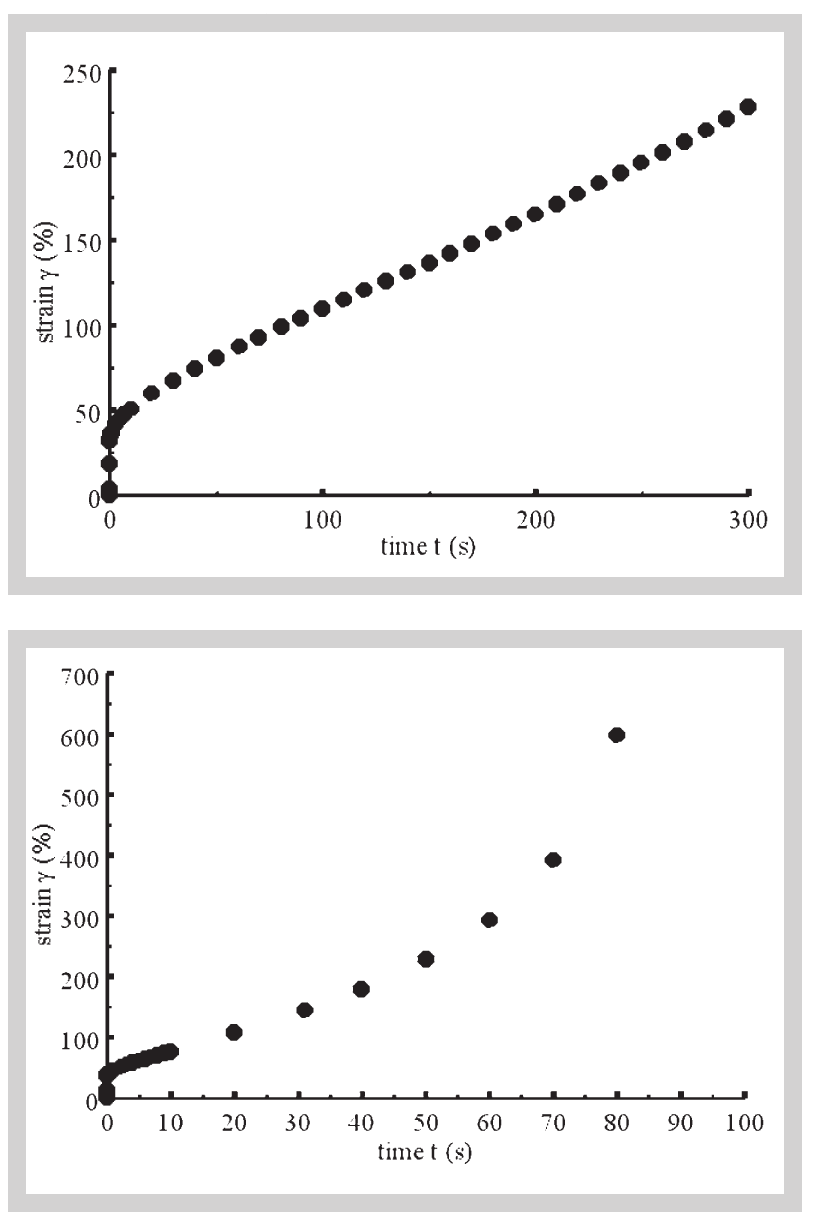
Figure 2: The strain response of a 1380 kg/m3 mud sample to a creep